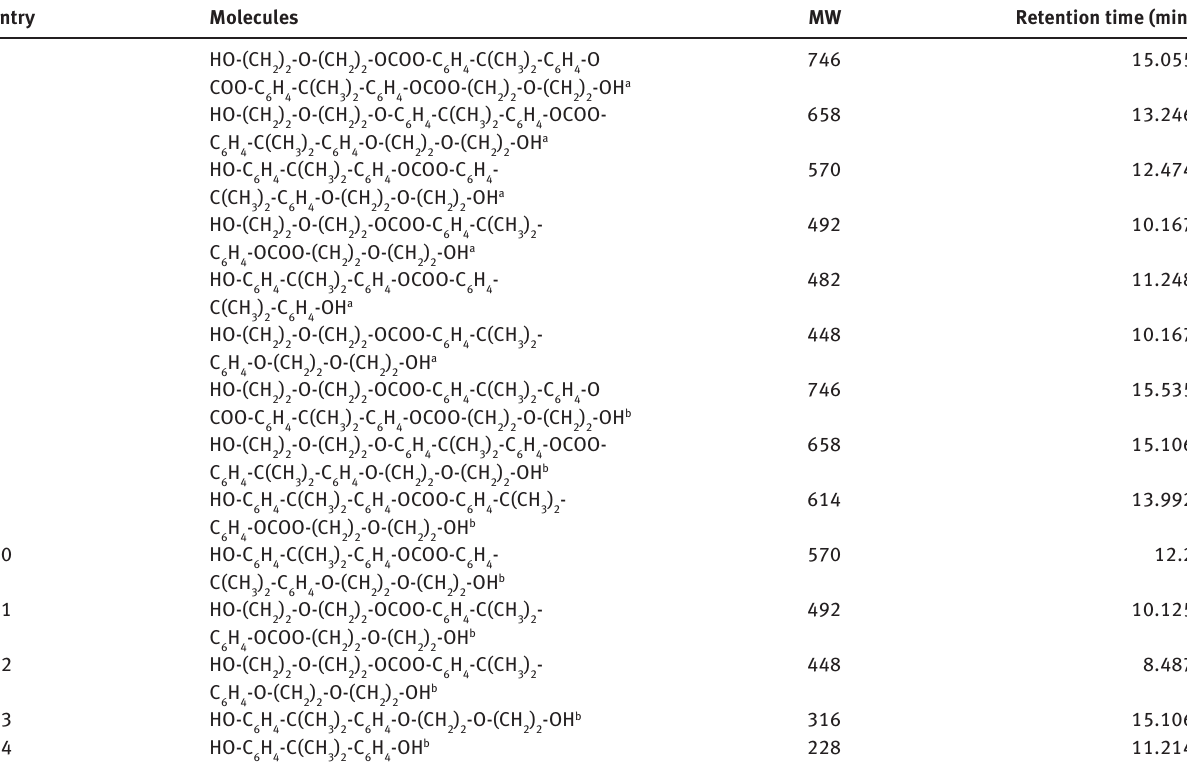
Table 4: The molecules characterized using GC-MS. Entry Molecules